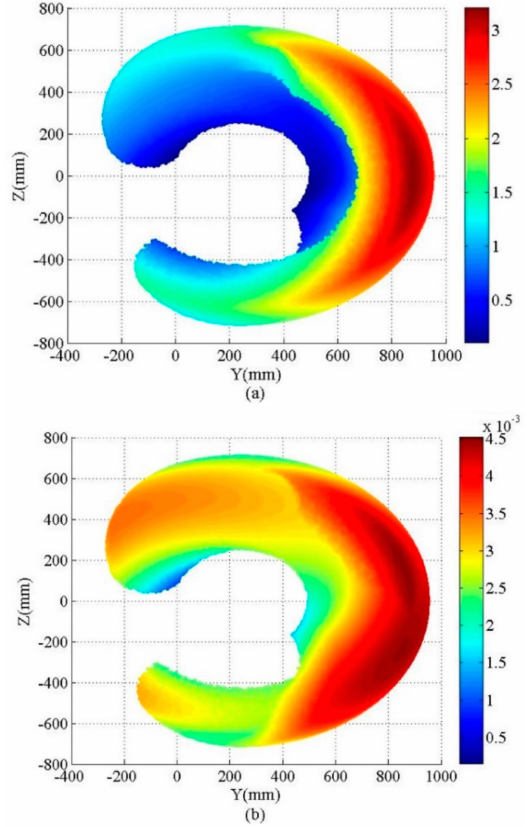
Figure 4. The error between the nominal pose and the actual pose of R1. The unit of position error in ( a ) is mm. The unit of orientation error in ( b ) is